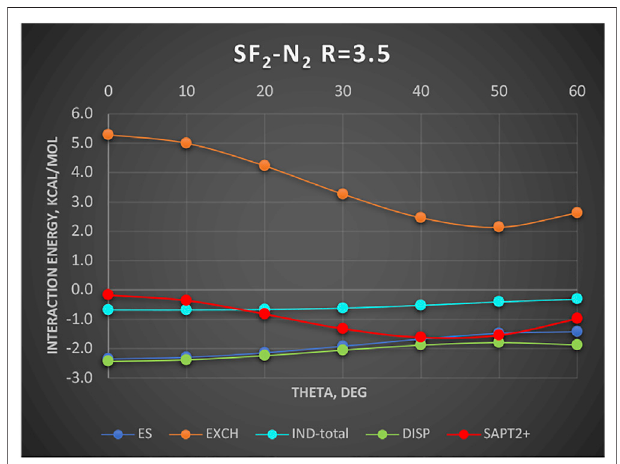
FIGURE 7 | SAPT2+ energy components of SF 2 -N 2 as a function of theta. Complex is described in Jacobi coordinates: R = 3.5 Å and theta = 0 ° corresponds to N 2 oriented at the C 2 axis on the S side. Values in kcal/mol.